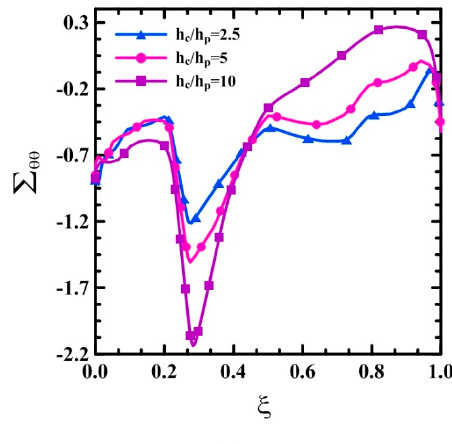
Figure 10. ( a – c ): Effect of the core thickness-to-piezoelectric thickness ratio h c / h p on the distribution of the thermoelastic field variables through the radial direction ( n = 1, θ 0 = 75 ◦ , θ = 0.5 θ 0 , ψ = 0.03, F 0 = 0.8, τ = 0.2).